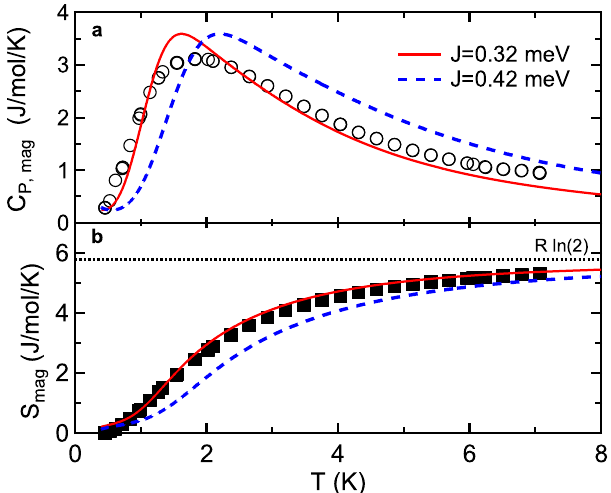
Fig. 5 Magnetic speci fi c heat capacity, entropy, and mTPQ calculations for YbCl 3 . Speci fi c heat capacity ( a ) and entropy ( b ) for YbCl 3 . The solid red line is the best fi t calculation using mTPQ as described in the text. The dashed blue line is the calculated speci fi c heat using mTPQ with the value J = 0.42 meV obtained by fi tting the INS